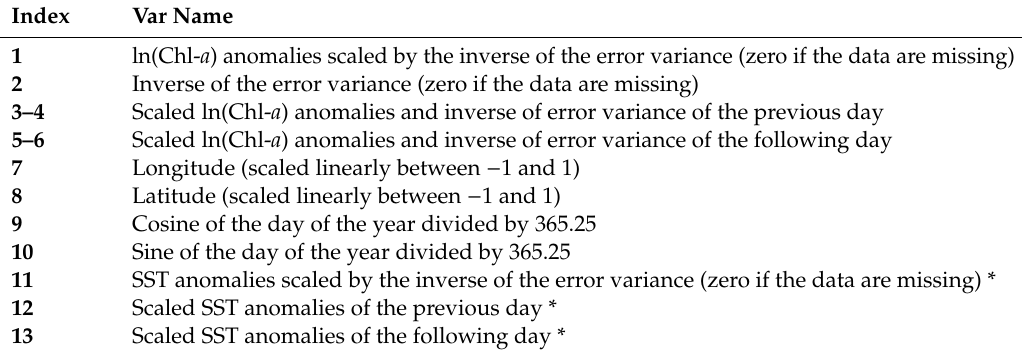
Table 2. The total list of input